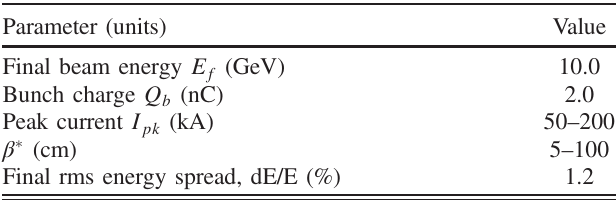
TABLE IV. Single-bunch, high Q mode parameters.